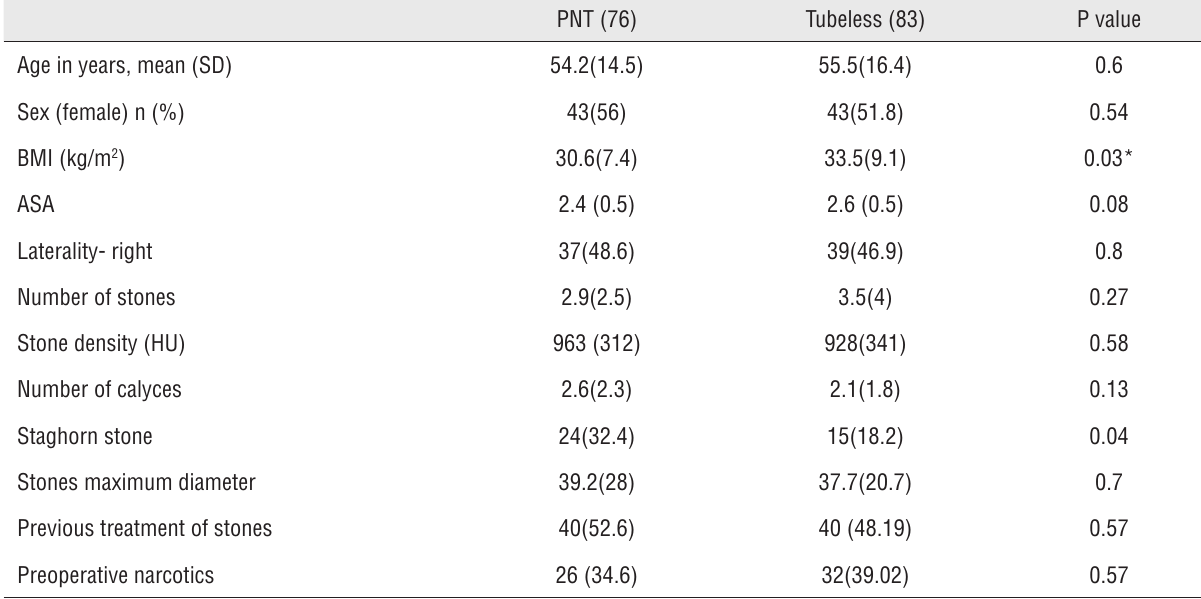
Table 1 - Pre-operative